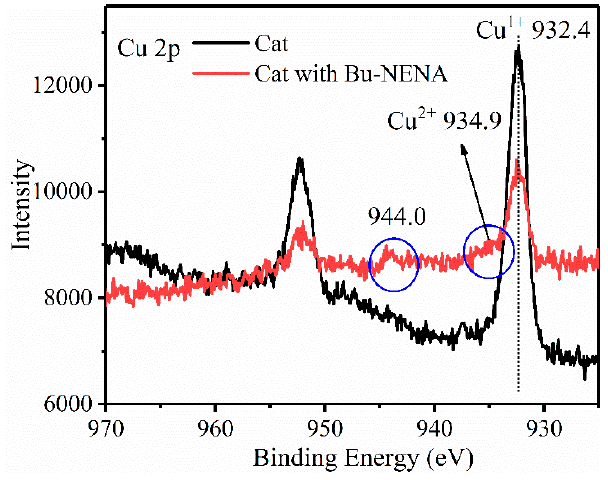
Figure 7. X-ray photoelectron spectroscopy (XPS) analysis of pure catalyst and Bu-NENA soaked catalyst.